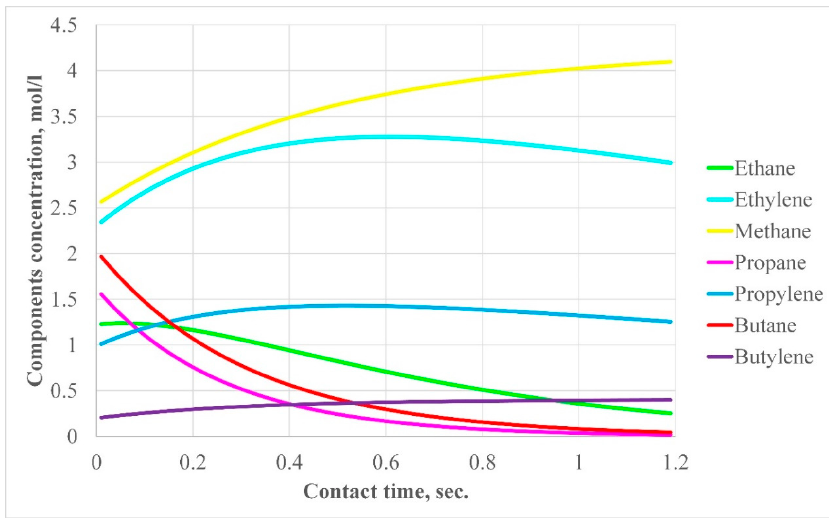
Figure 3. Change in the concentration of the components during the process.